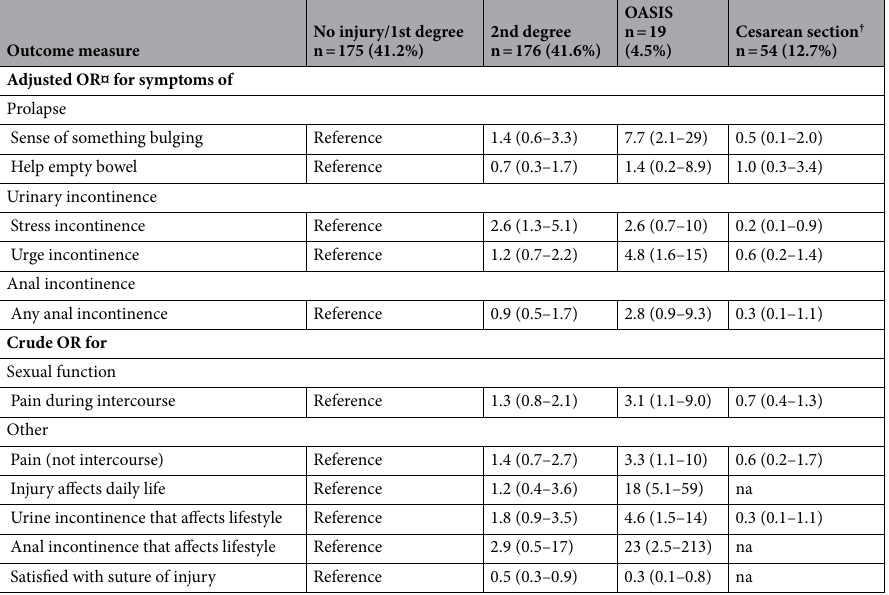
Table 3. Degree of trauma and odds ratios for symptoms of prolapse, urinary incontinence, anal incontinence, sexual function and other outcomes. † Cesarean section was compared to vaginal delivery. Data are OR (95%CI) ¤ Adjusted for age and fetal weight and BMI na = not